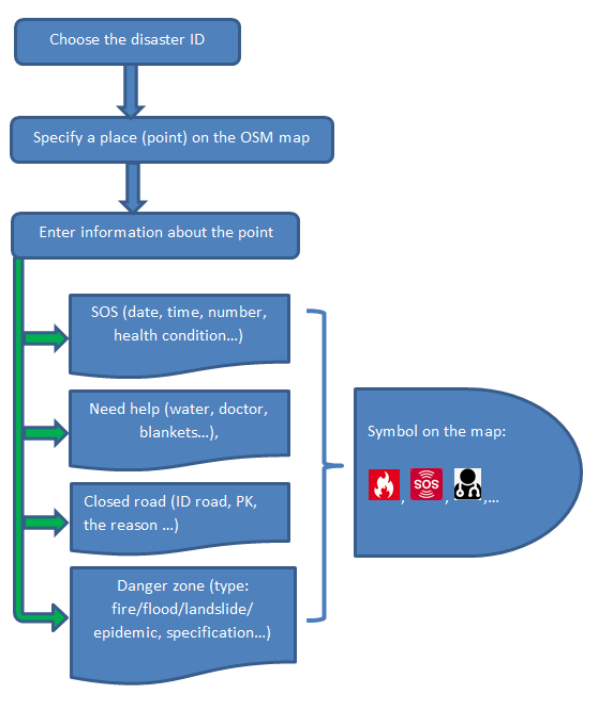
Figure 6. Figure Platform